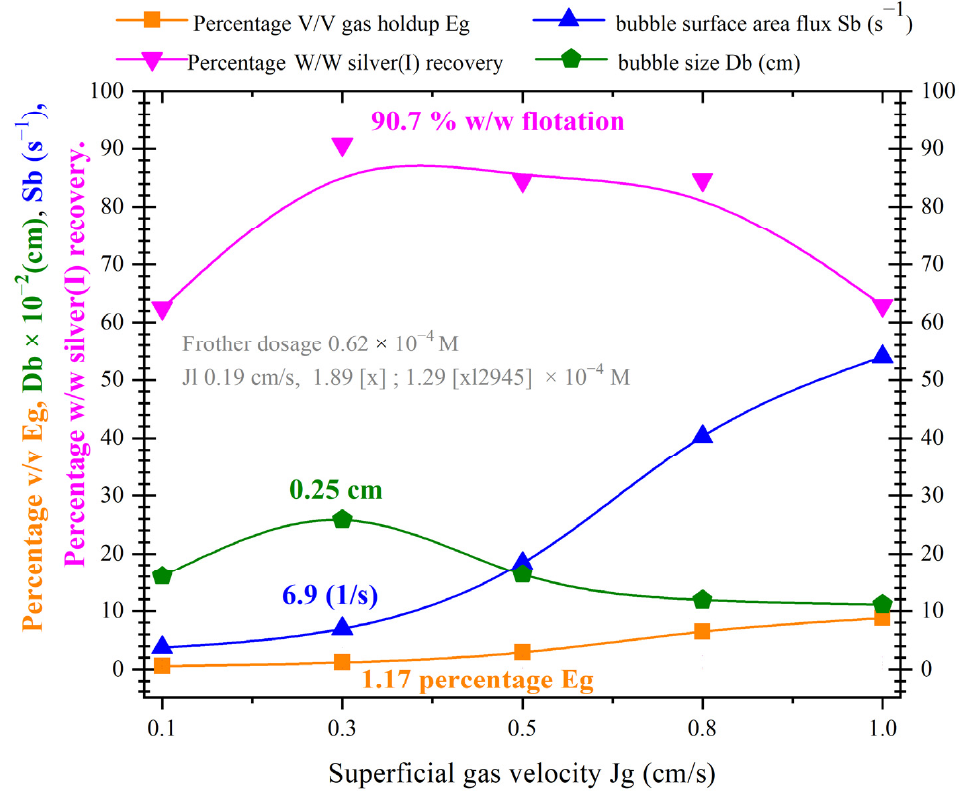
Figure 16. Eg, Db, Sb, and percentage of w / w of silver(I) ion flotation as function of superficial gas velocity, ceramic sparger, Jl 0.19 cm/s, system 1.89 × 10 − 4 M of [x]–1.29 × 10 − 4 M [xl2945], and [e] 0.62 × 10 − 4 M.